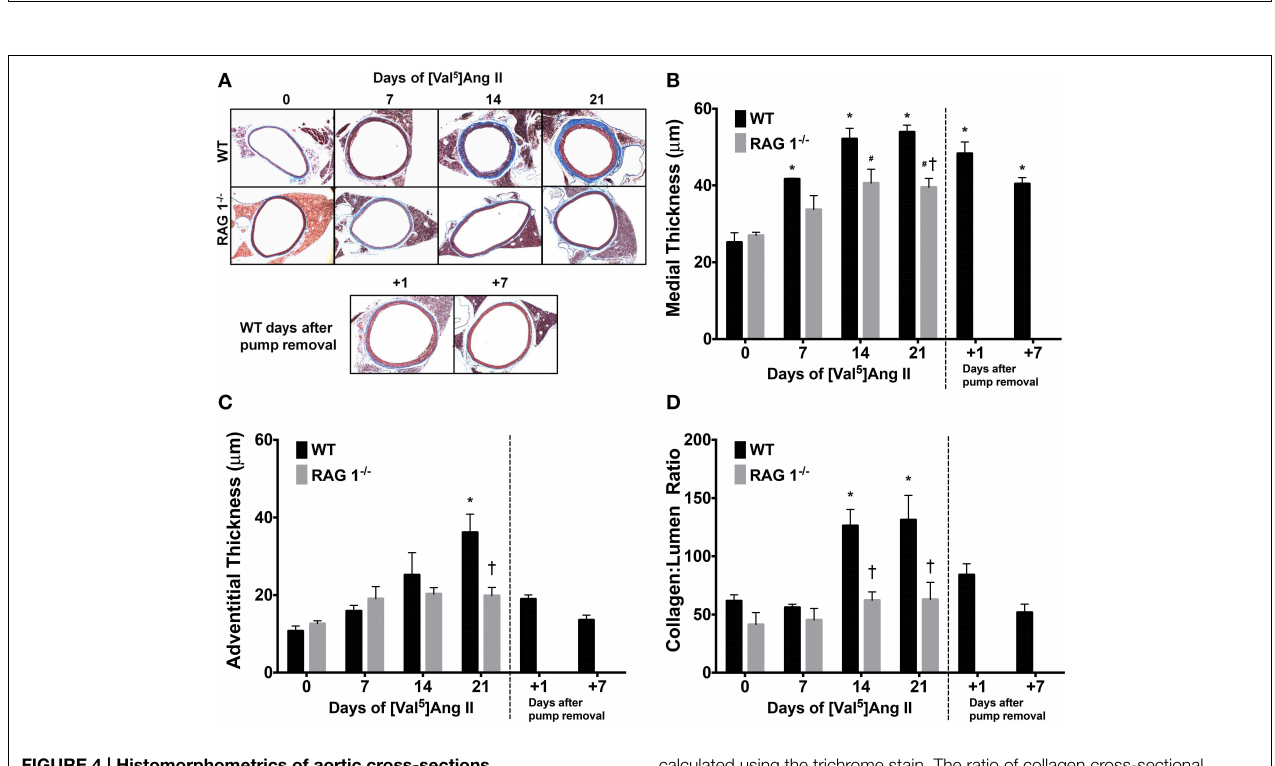
calculated using the trichrome stain. The ratio of collagen cross-sectional area to lumen area was measured by Picrosirius red staining (D) . * P < 0 . 05 vs. day 0 of WT; # P < 0 . 05 vs. day 0 of RAG 1 − / − ; † P < 0 . 05 between different strains at each time point. N = 6 . Data are means ± SEM.